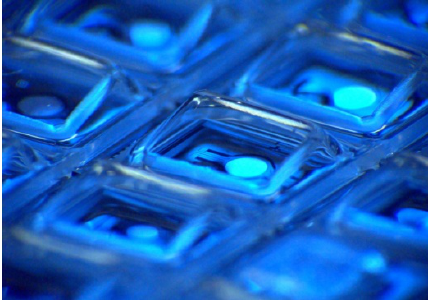
Figure 24. Wafer level vacuum packaged MEMS mirrors with tilted glass windows.